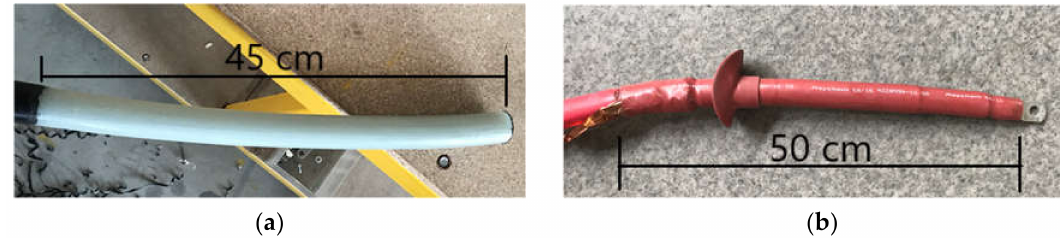
Figure 5. Preparation of cable samples: ( a ) stripping of the semiconductor layer and ( b ) measured cable